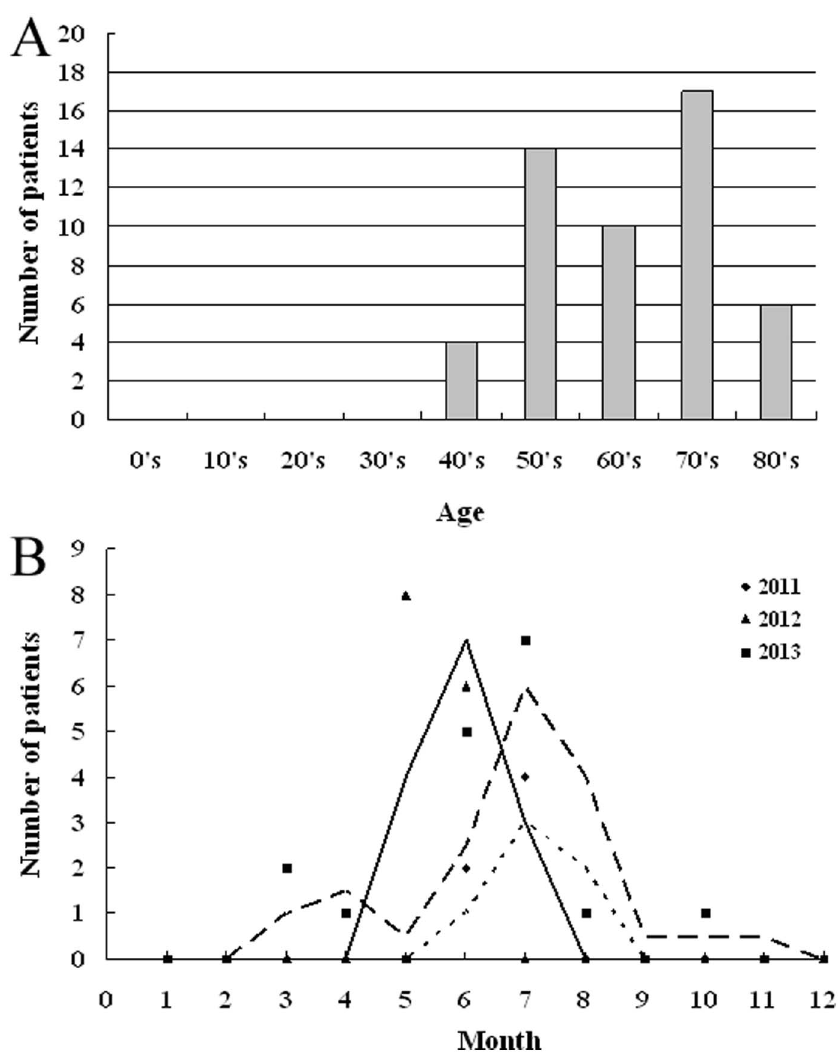
Figure 1. Surveillance results for SFTS in Daishan, Zhejiang Province. A: Age distribution of diagnosed SFTS patients in Daishan from 2011 to 2014. B: Seasonality distribution of identified SFTSV infection cases in Daishan from 2011 to 2013.